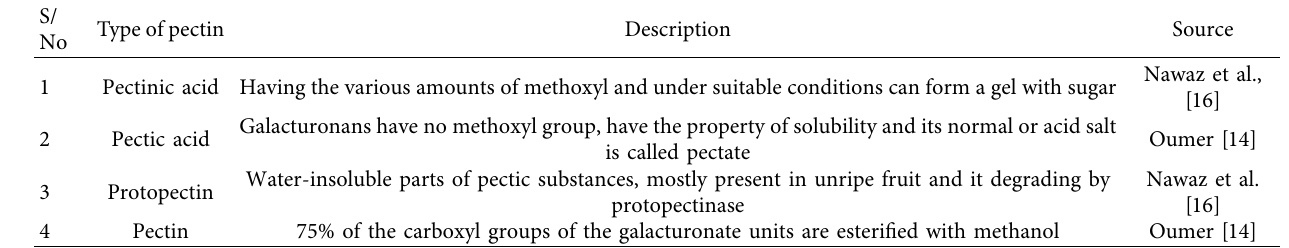
Figure 1: Structure of pectin and its functional groups [14]. Table 1: Type of pectic substances and its description.